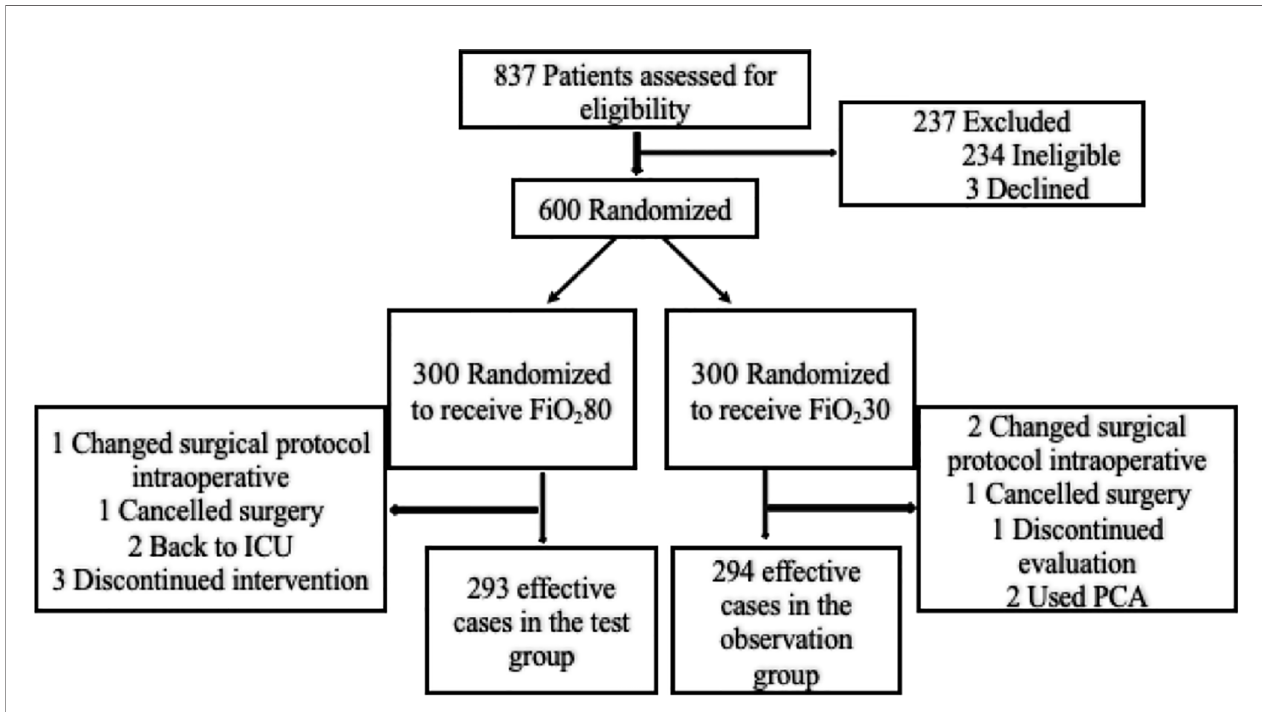
FIGURE 1 | CONSORT Flow Study